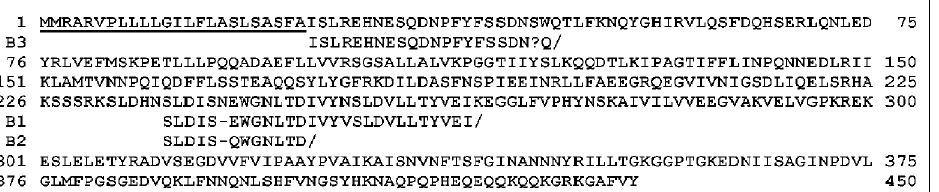
Figure 2 - N-terminal amino acid sequences of phaseolin polypep- tides. N-terminal amino acid se- quences of the polypeptides B1, B2 and B3 from fraction F1 aligned with the sequence of Phaseolus lunatus phaseolin as deduced from c-DNA data re- ported by Kami and Gepts (18). Underlined residues correspond to the signal sequence of phase-